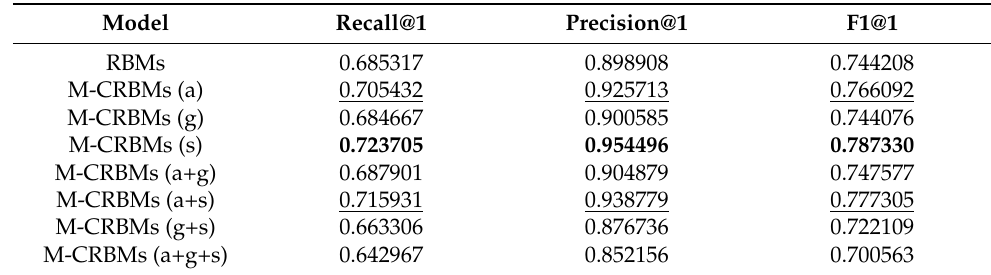
Table 1. Recall@1, precision@1, and F1@1 of M-CRBM models clamped with different extra informa- tion. The results were taken from the final training epoch. The bold text indicates the best results in the column, and the underlined values are the second- and third-best results in the column. Model